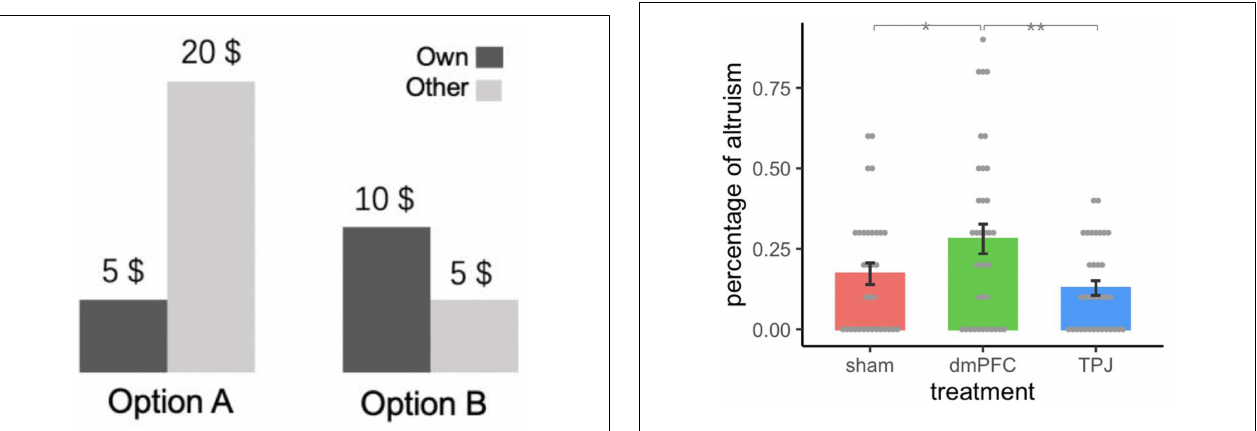
FIGURE 1 | Experimental procedure. Participants faced many decision problems in the dictator game. They had to choose one of two payoff allocations (“options”) that assigned money to the participant (own) and an anonymous other. Subject could make an altruistic choice (i.e., option A) that increases other’s payoff (other gets $15 more, benefit = $15) at a cost to participant (gets $5 less, cost = $5).